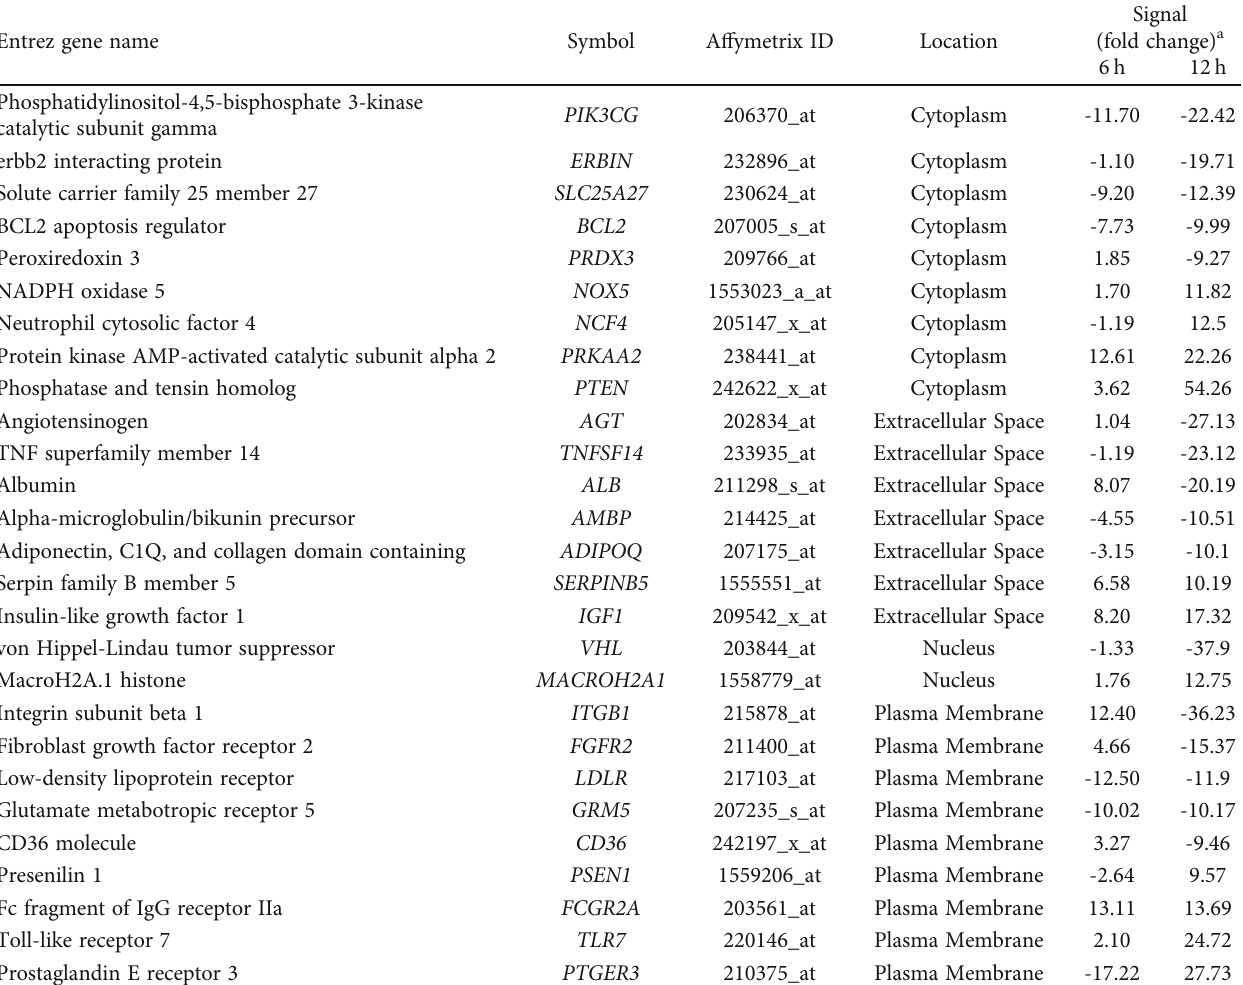
Table 1: Genes related to the transcriptomic network of the quality and freshness of starved human bone marrow-derived mesenchymal stem cells